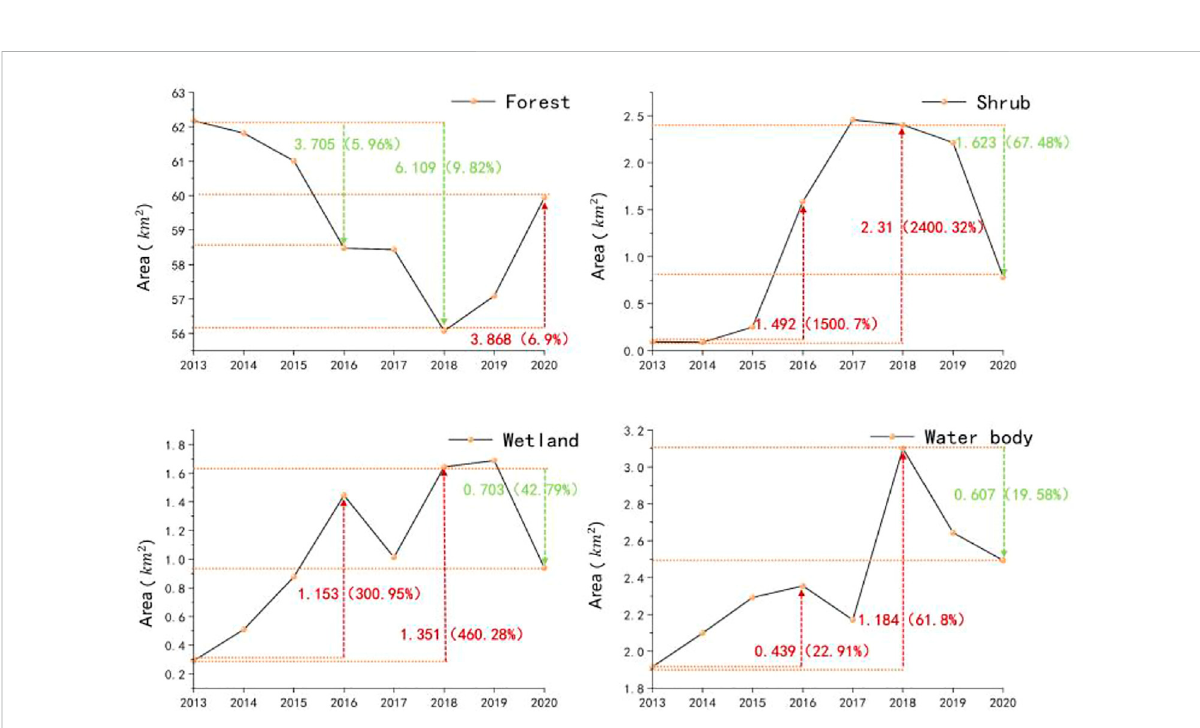
FIGURE 4 Main land cover changes in Jiuzhaigou Scenic